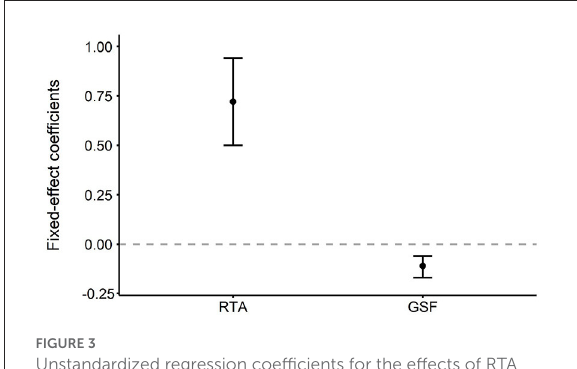
FIGURE3 Unstandardized regression coefficients for the effects of RTA and GSF on choice behavior. Both the RTA and the GSF were significant factors in predicting UG decisions. Error bars indicate 95% confidence